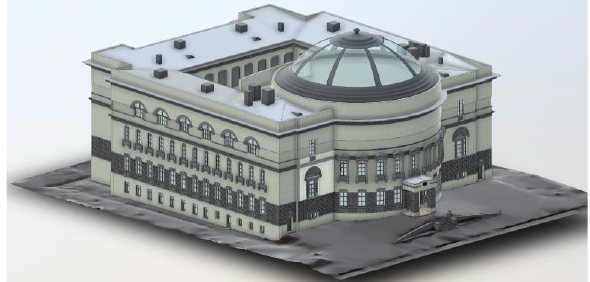
Figure 4 . BIM Model of Kyiv Teacher’s